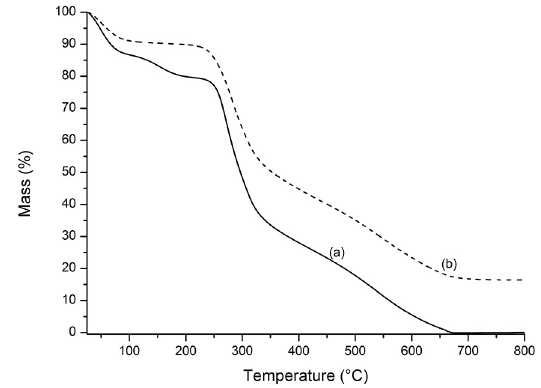
Figure 1. TG curves of (a) QN and (b) QNM. shows mineral deposits constituted of few apatite particles after two mieralization cycles (Figure 2B). Mineralization process decreases both the quantity and the pore size, as QNM had value of pore size of 39.2 ± 2.8 µm.